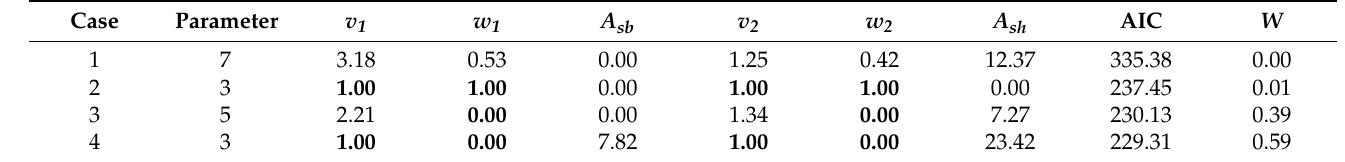
Table 4. Parameters of catch function fit and data for multi-model selection.